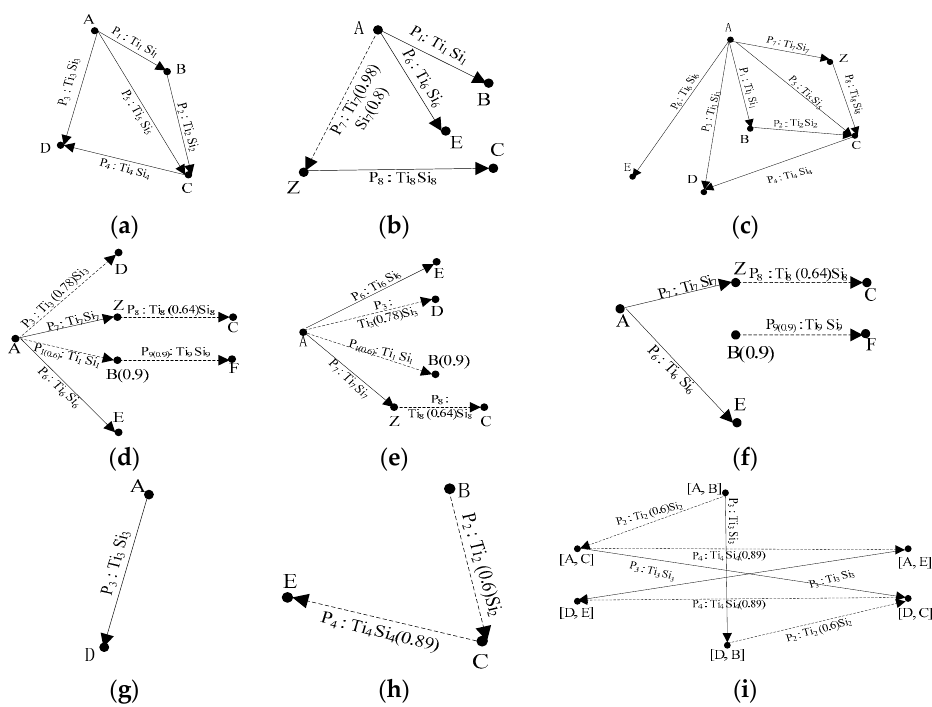
Figure 3. Algebraic operations of stRDFS graphs.